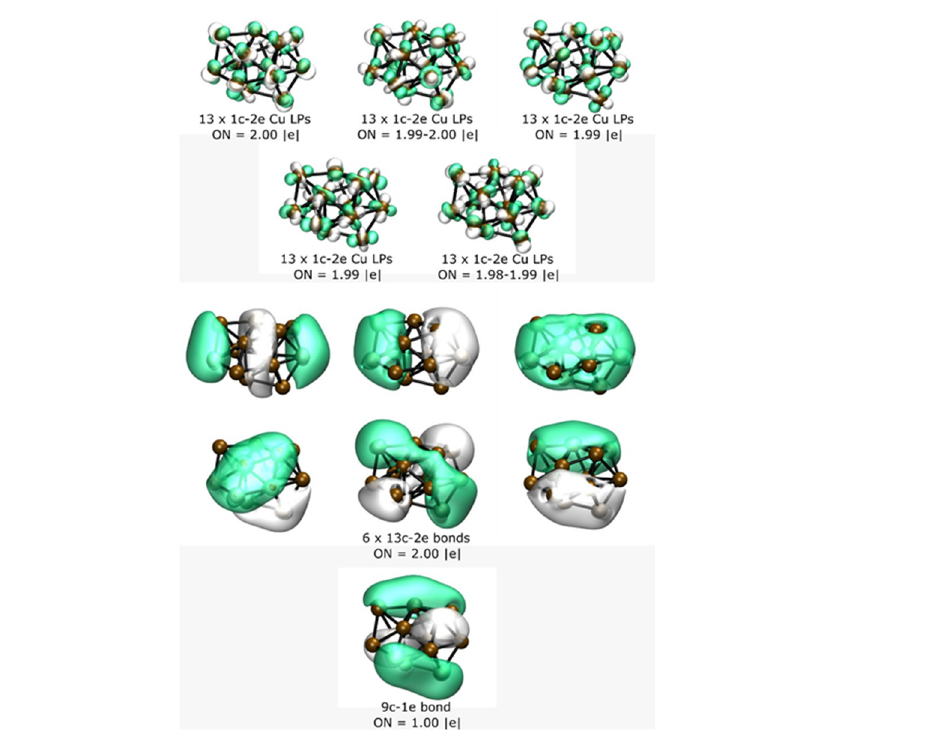
Figure 2. (Color online) Results of the AdNDP analysis of the lowest energy isomer of the Cu 13 system.